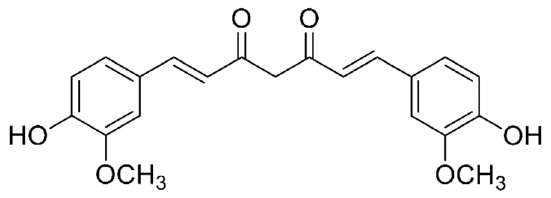
Figure 1. The chemical structure of curcumin.